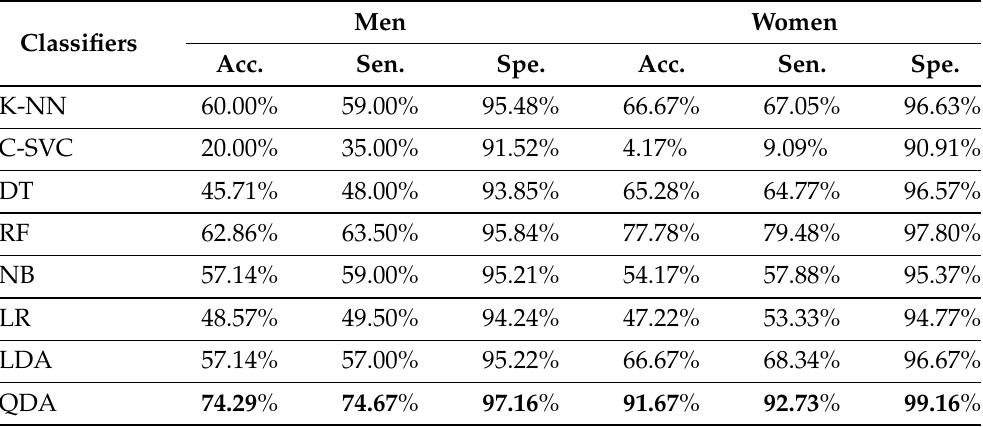
Table 2. Machine-learning Accuracy (Acc.), Sensitivity (Sen.) and Specificity (Spe.) with SMOTE by